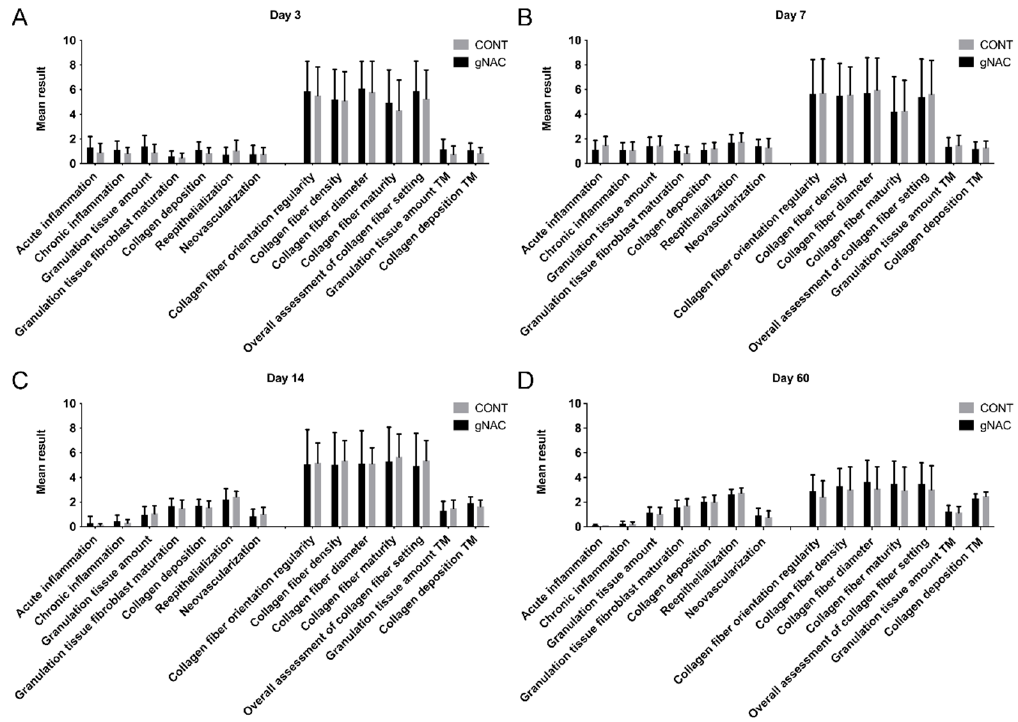
Figure 3. Graph presents results of histological analysis with Abramov scale. Results of groups NAC15, NAC30, and NAC45 collectively analyzed as gNAC. ( A ) Day 3, ( B ) day 7, ( C ) day 14, ( D ) day 60. Mean values are shown. Error bars are SD. TM—Masson’s Trichrome stained images.